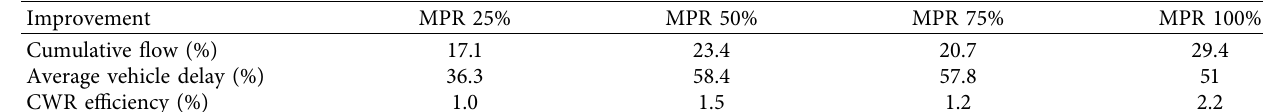
Table 8: Efect of CWR intersection signal control: intersection type 3.